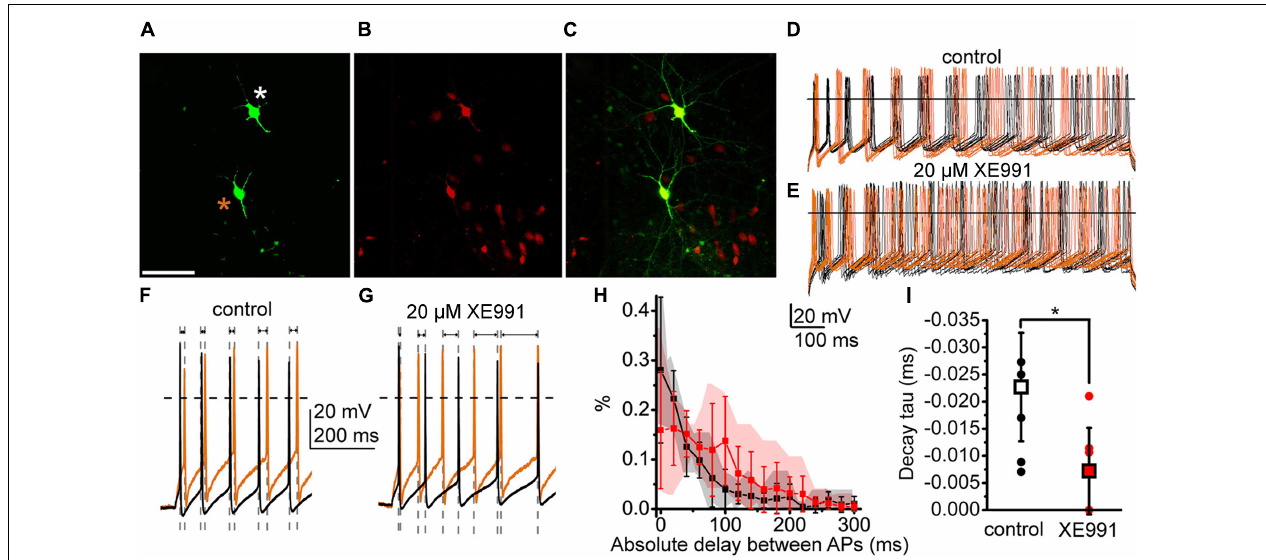
FIGURE 7 | The M-current of PPN cholinergic neurons can control the synchronization of the neighboring neurons. (A–C) Two cholinergic neurons labeled in the PPN during recordings ( asterisks ). (A) Biocytin labeling ( scale bar , 100 µ m). (B) ChAT-dependent tdTomato expression. (C) Merged image. (D,E) Action potential series elicited by 100 pA depolarizing stimuli from the two neighboring neurons under the control conditions (D) ( brown traces : recordings from the neuron labeled with brown asterisk ; black traces : recorded from the neuron labeled with white asterisk ) and in the presence of the M-current inhibitor XE991 (E) . (F,G) Representative pairs of traces taken from panels (D,E) at high time resolution under the control conditions (F) and with XE991 (G) representing changes of the delay intervals between spikes (indicated with gray dashed lines and arrows ). (H) Mean histograms of absolute delays between the action potentials recorded from the neighboring neurons with 20-ms bins (mean ± SD; black : control; red : with XE991; gray and pink clouds : ranges of individual data). (I) Decay tau values obtained with the fit of the individual histograms of absolute delays under the control conditions ( hollow square and black dots ) and with XE991 ( red square red dots ). Squares represent means and dots represent individual